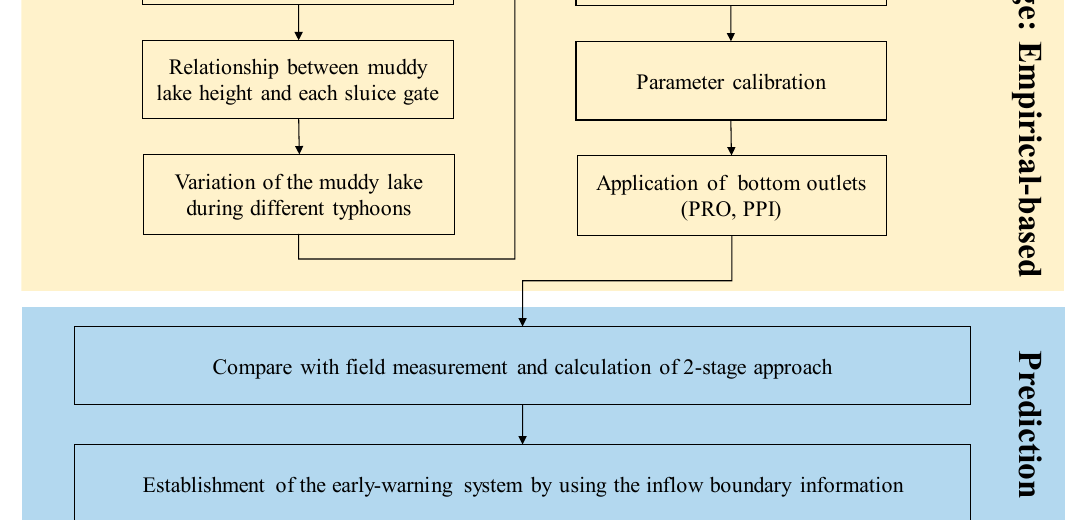
Figure 1. Flowchart of the investigation framework for this two-stage approach.